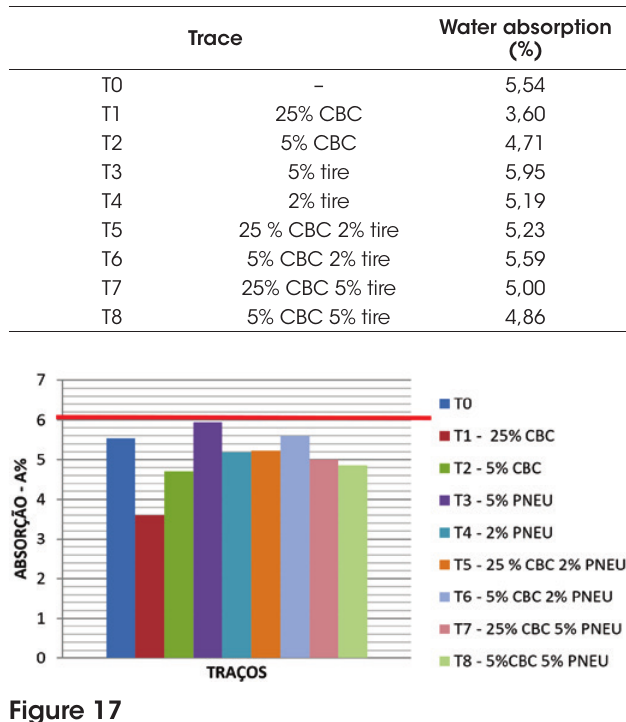
Water absorption